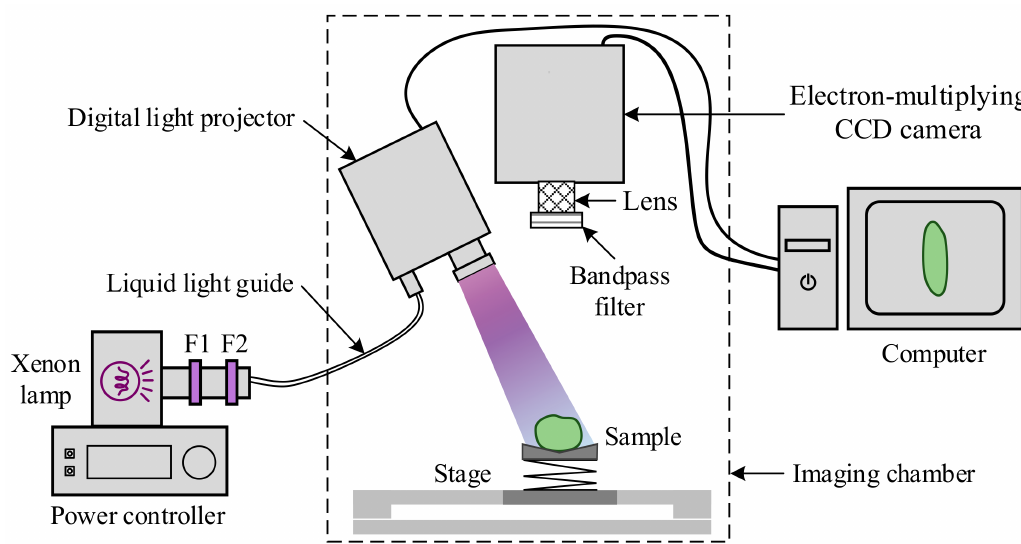
Figure 3. Schematic of a chlorophyll fluorescence imaging system for detecting chilling injury on pickling cucumbers, where F1 and F2, representing a bandpass (400 ± 70 nm) and a lowpass (<470 nm) filter, respectively, were used in combination with a Xenon lamp for generating ultraviolet-blue excitation light for chlorophyll